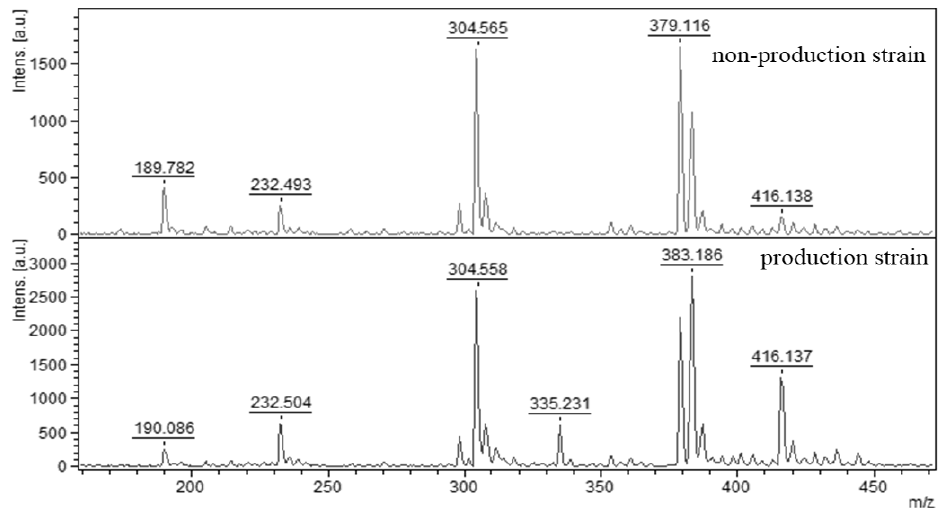
Figure 4. MALDI-TOF mass spectra of AFB 1 obtained by isolation from medium around the Aspergillus flavus mycelia. Producing strain (335.231 m/z) and non-producing strain (without peak of alfatoxin B 1 ).